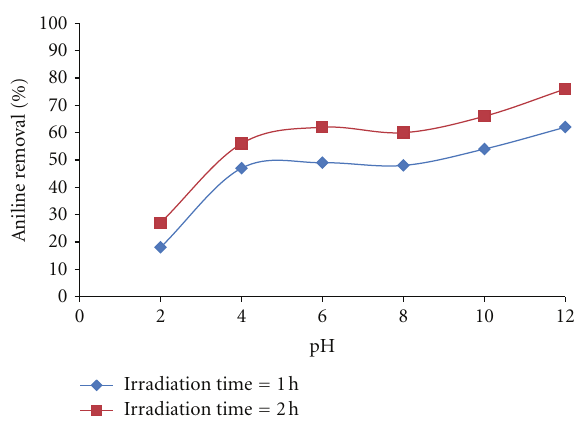
Figure 4: E ff ect of pH on aniline removal at two typical irradiation times (1h and 2 h); (catalyst concentration: 60mg/L and T = 293K.)